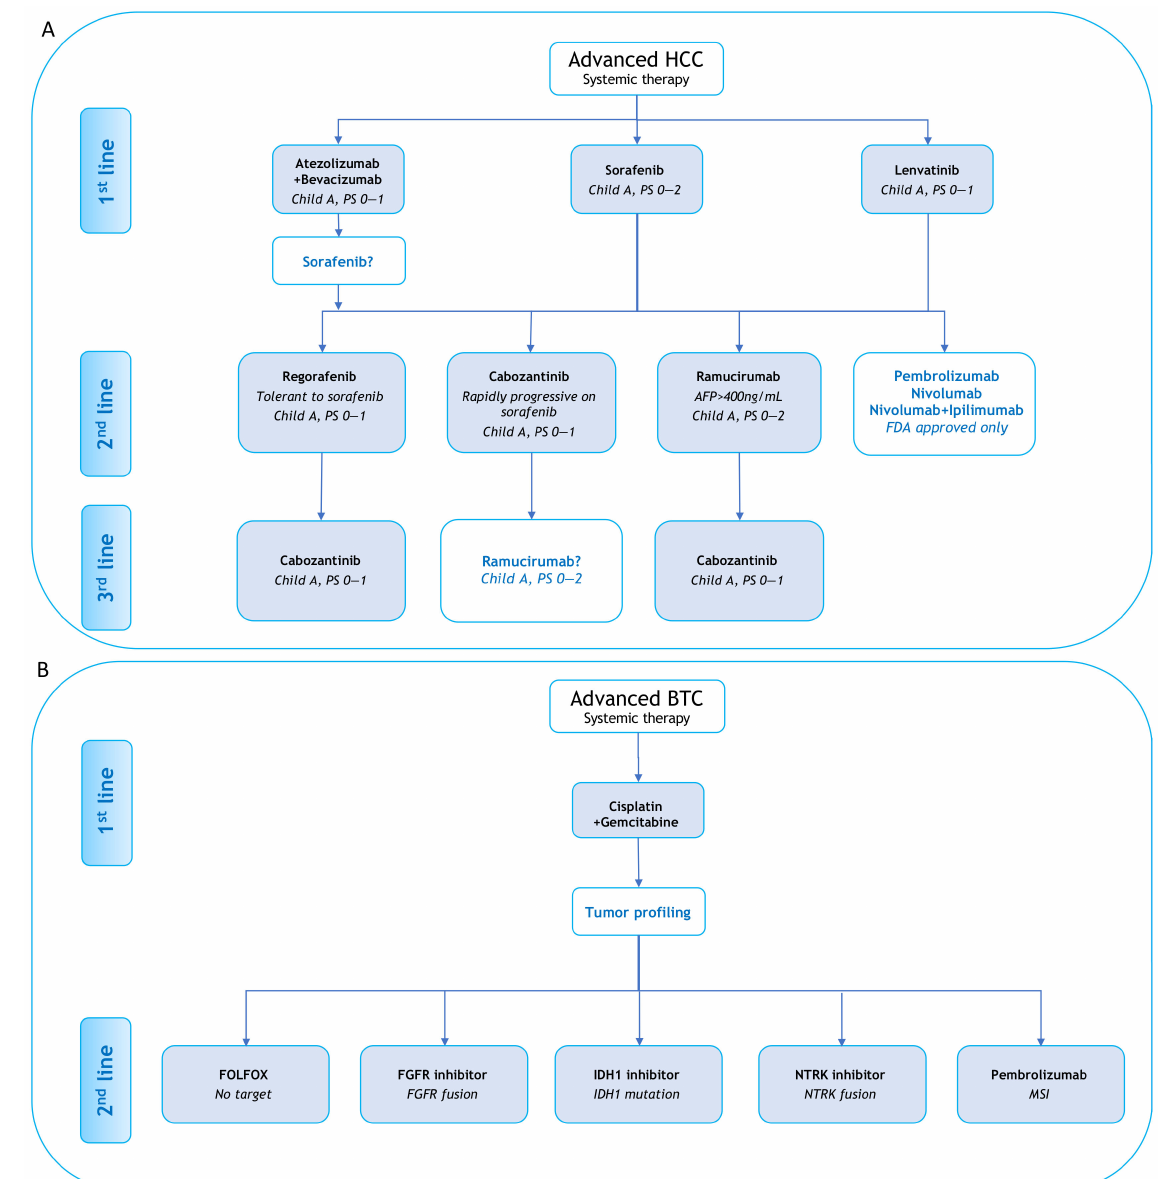
Figure 1. Systemic treatments for advanced hepatocellular carcinoma ( A ) and biliary tract cancers ( B